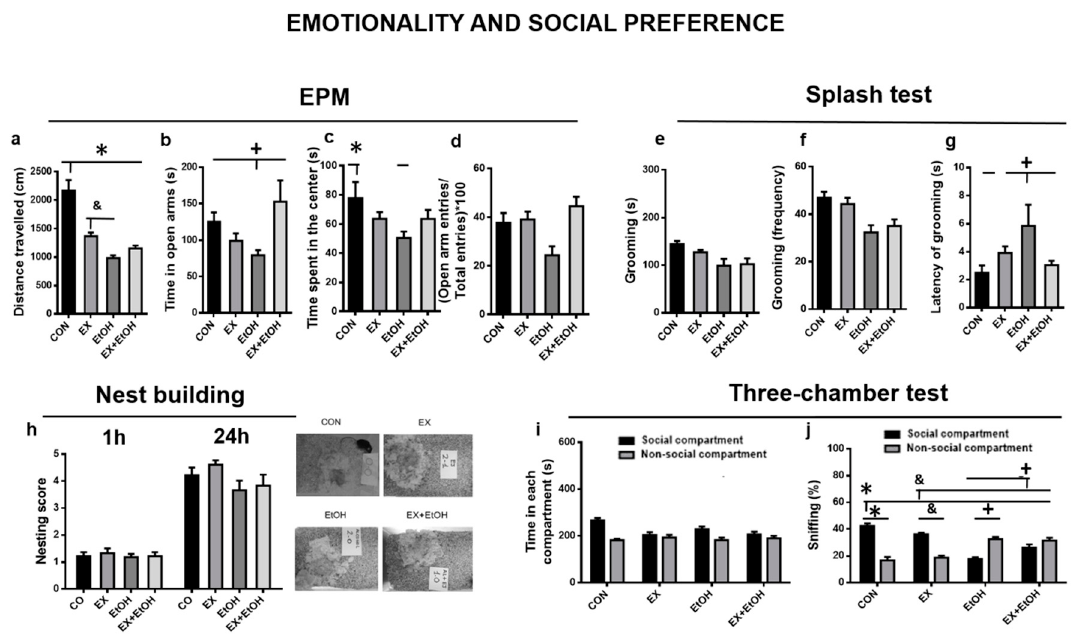
Figure 3. Behavioral performance in Emotionality and Social preference. ( a – d : Elevated-plus maze; e – g : Sucrose splash test; h : The nest building test and representative photographs of nests from the di ff erent experimental conditions at 24 h; i , j : Three-chamber test). All data are mean ± SEM, and statistically significant di ff erences were considered when p < 0.05. * Statistical di ff erences between the CON group compared to other groups; + Statistical di ff erences between the EtOH group compared to other groups; statistical di ff erences between the EX group compared to other groups.